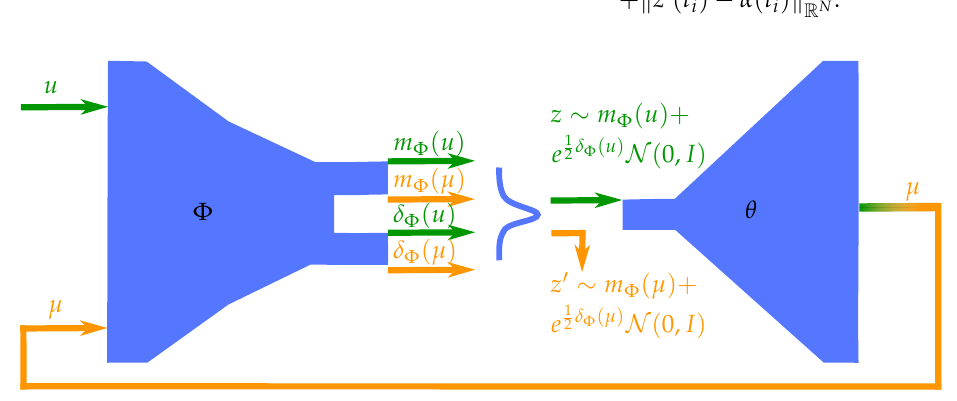
Figure 2. Schematical representation of the proposed data-targeted